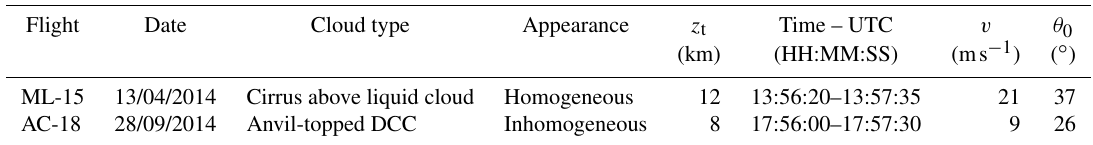
Table 1. Flight descriptions and atmospheric conditions during cloud measurements. Horizontal wind speed v and solar zenith angle θ 0 are averaged during the selected time series.